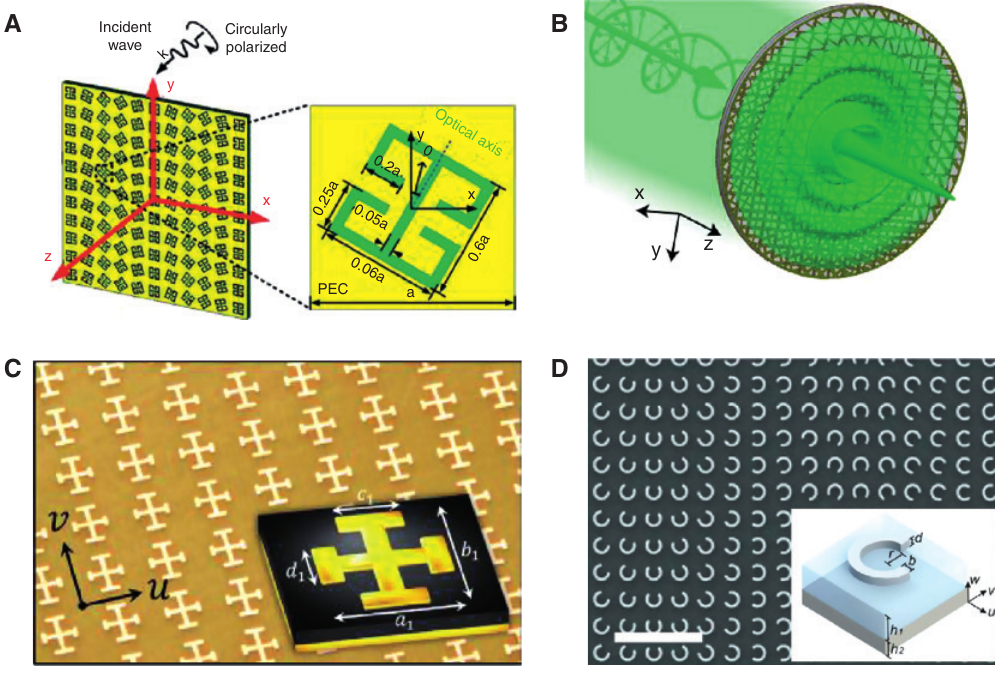
Figure 5: High efficiency geometric-phase metasurfaces. (A) High-efficiency geometric-phase metasurface in transmission geometry. Reprinted from Ref. [82]. (B) High-efficiency vector Bessel beams generator. Reprinted from Ref. [83, 84]. (C and D) Almost perfect OSHE in reflection geometry working in microwave and tetrahertz region. (C and D) Reprinted from Refs. [85, 86],